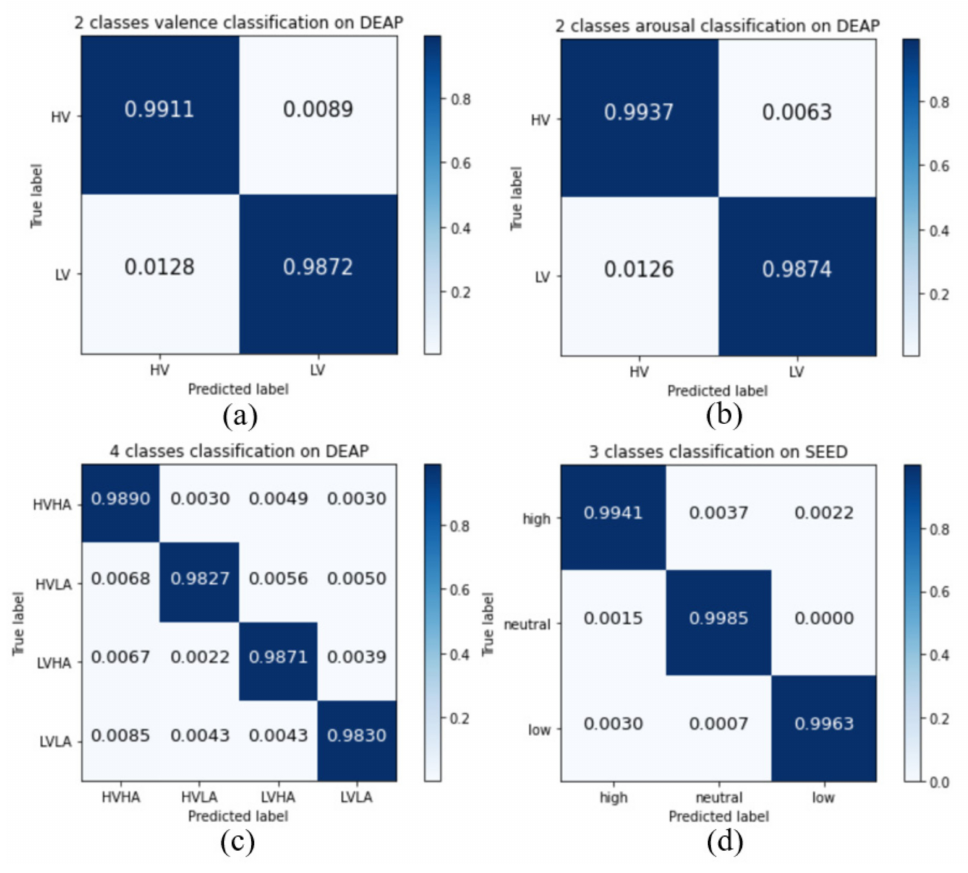
Figure 5. Confusion matrices of ( a ) two-class valence, ( b ) two-class arousal, ( c ) four-class classification for the DEAP, and ( d ) three-class classification for the